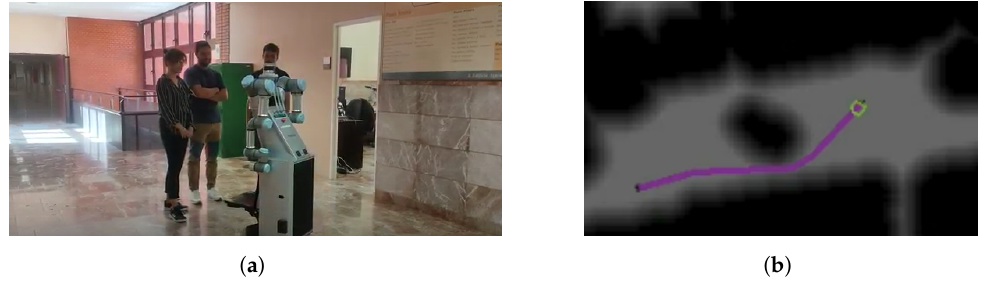
Figure 29. Social navigation example of the robot in a real scenario with three people. ( a ) Initial scenario with a group of three people interfering with the initial path; ( b ) replanning of the path acoording to their personal space.